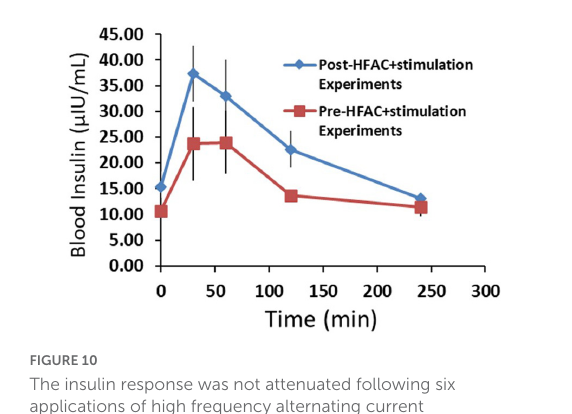
FIGURE10 The insulin response was not attenuated following six applications of high frequency alternating current (HFAC) + stimulation (Post-HFAC + stimulation Experiments) vs. Sham (Pre-HFAC + stimulation Experiments). n = 3 swine Error bars are